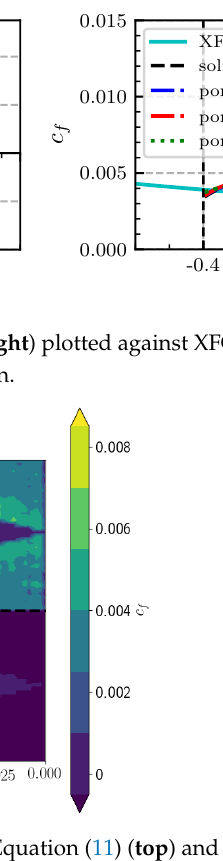
Figure 6. Contours of the total shear stress Equation (11) ( top ) and the viscous shear stress contribu- tion ( bottom ) on the poro-serrated trailing